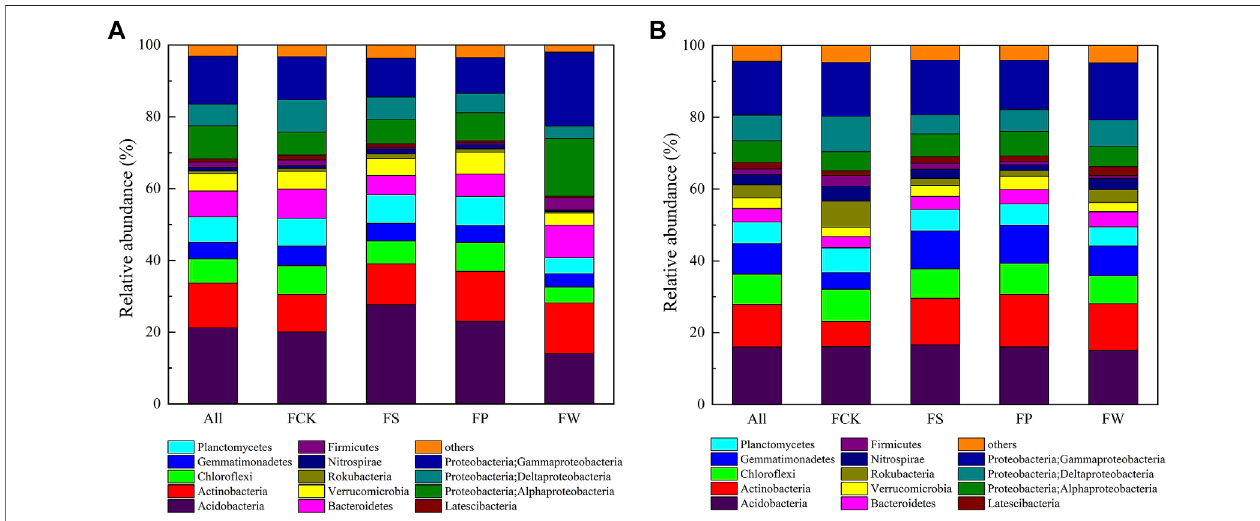
FIGURE 1 | Relative abundances of dominant bacterial phyla/classes in topsoil (A) and subsoil (B) among different sites. Relative abundances are based on the proportional frequencies of 16S rDNA sequences that could be classi fi ed at the phyla/classes level. Note: All, the whole soil samples; FCK, non-subsidence site (wheat- maize rotation); FS, reclamation site with pagoda trees; FP, reclamation site with peach trees; FW, reclamation site with wheat-maize rotation.